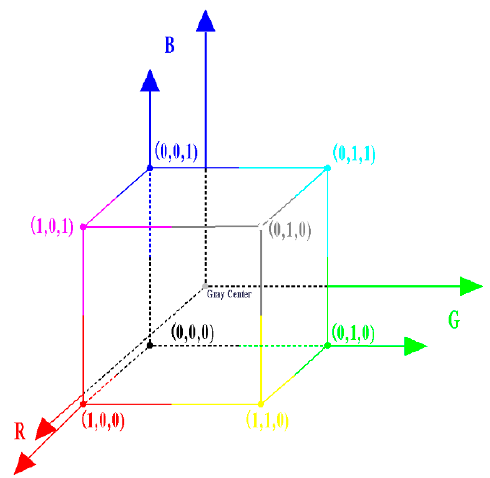
Figure 1. Conversion of RGB color space to gray-center RGB color space: origin at O in the RGB color space coordinate system is moved to O ′ to form a new RGB color space coordinate system.